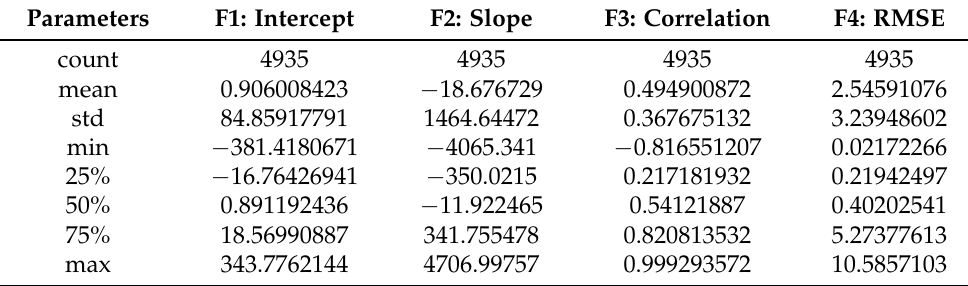
Table 2. Statistical information of ZCP dataset with noise level from 10% to 50%. Parameters